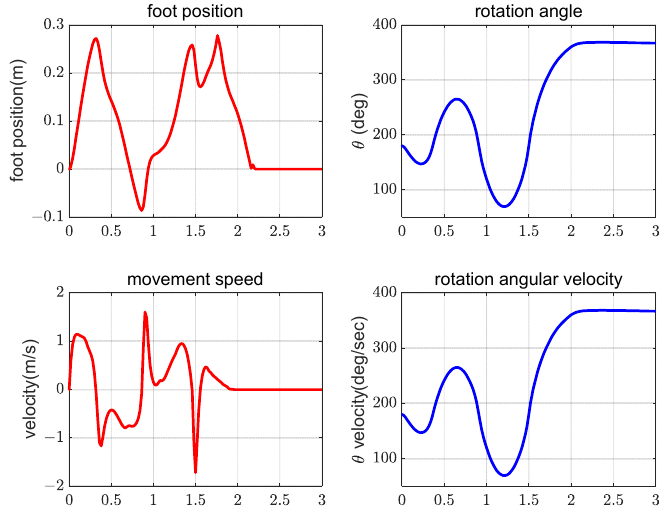
Figure 12. DDPG control with interference.